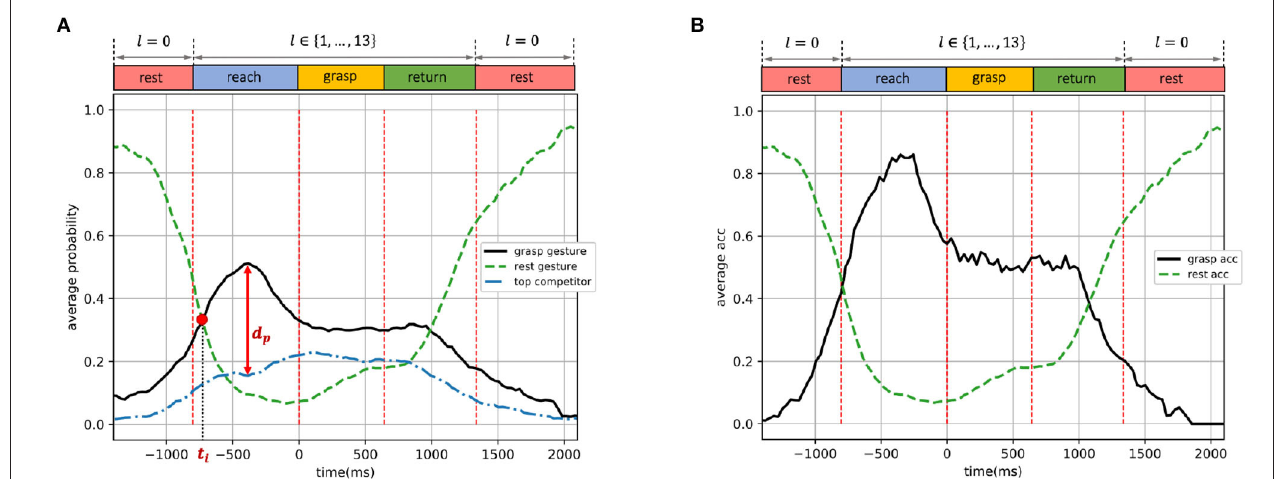
FIGURE 7 | Dynamic-EMG gesture classifier trained by the first strategy (reaching and resting phases): predicted probabilities and accuracy on validation set, presented as functions of time. (A) Average predicted probabilities. (B) Average accuracy.